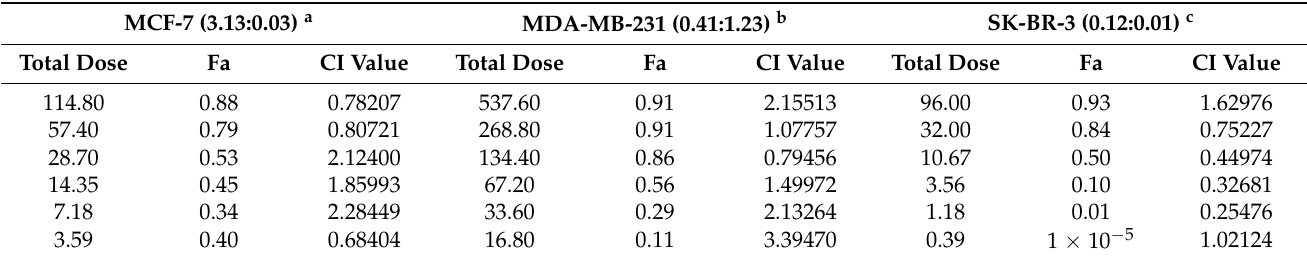
Table 11. Fa and CI values for actual experimental points of irinotecan combined with sunitinib.